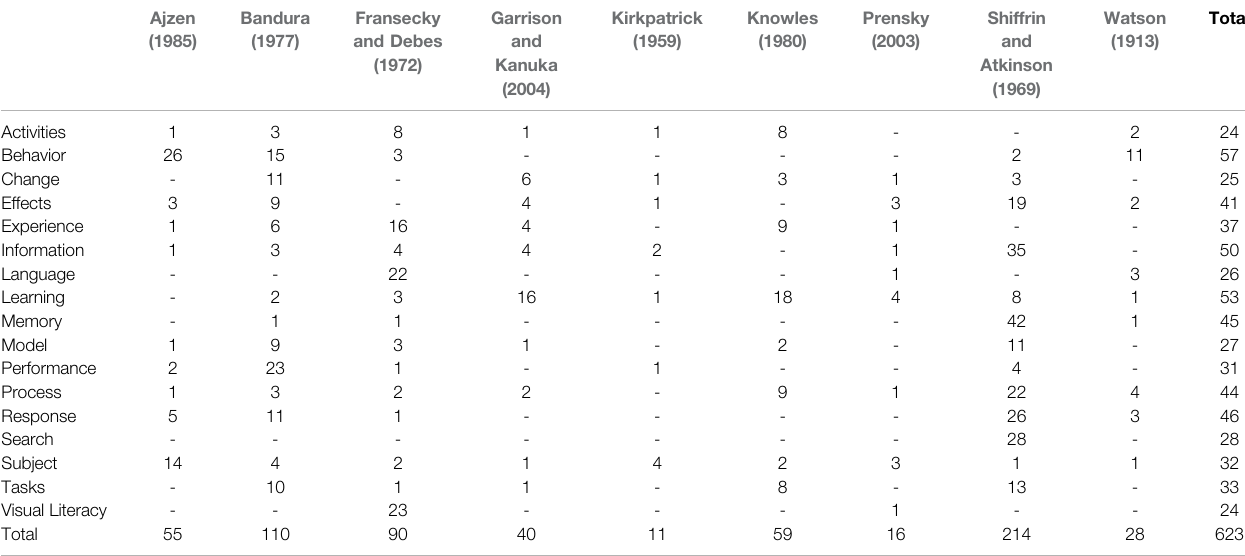
TABLE 5 | Frequency of terminology in foundational education